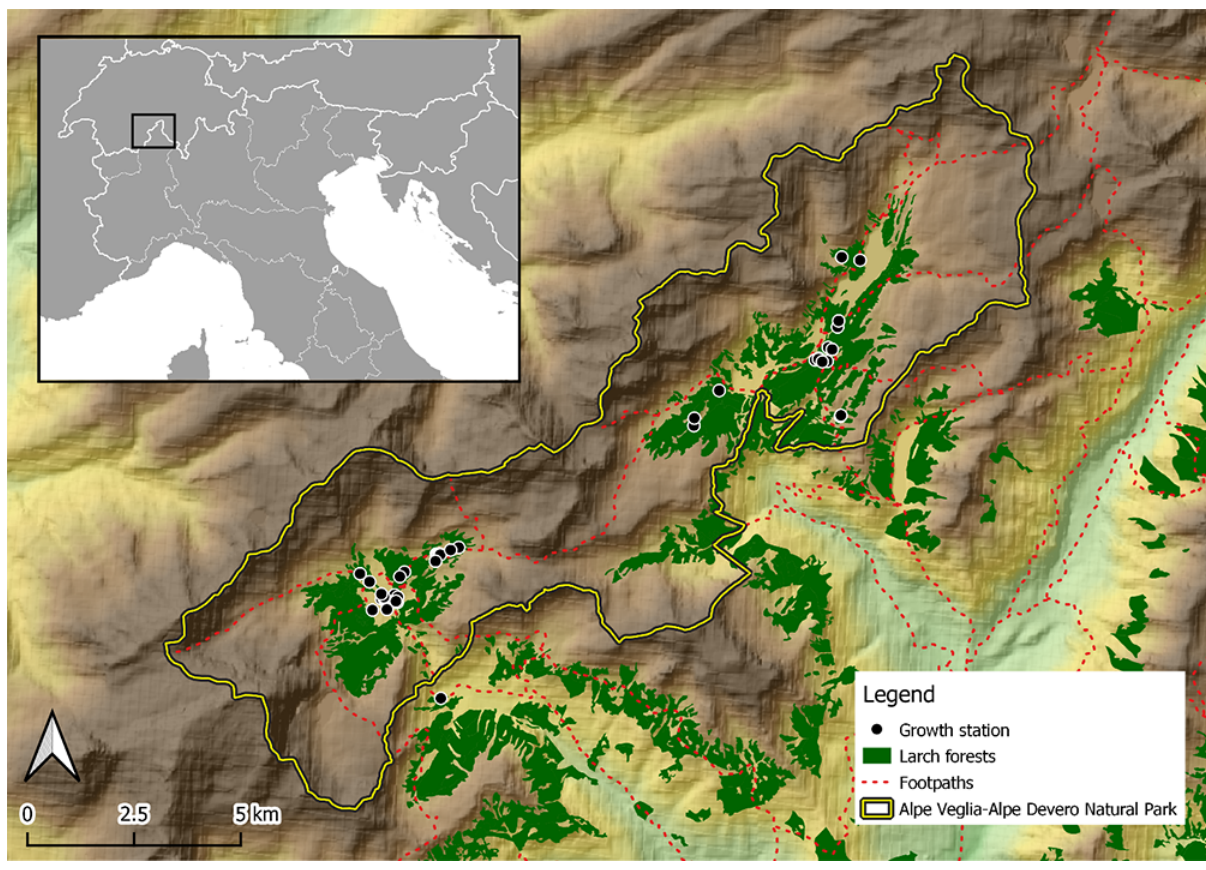
Figure 2 Detailed map of Alpe Veglia and Alpe Devero in Val d’Ossola. Black dots indicate host trees of Laricifomes officinalis